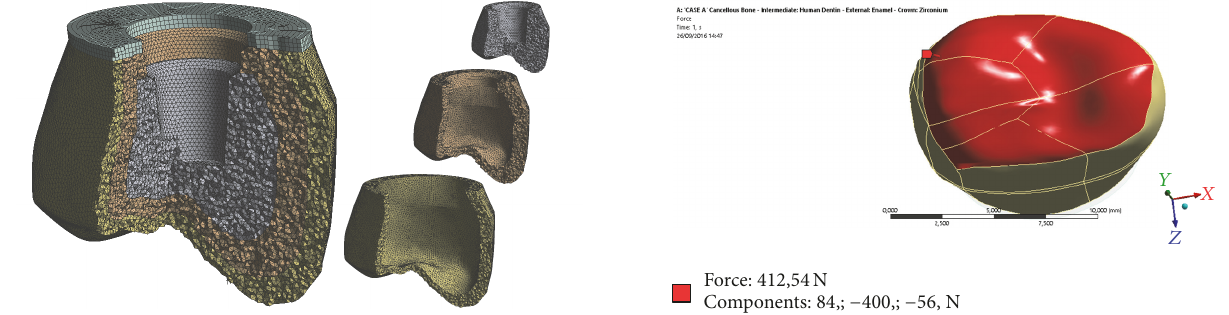
Figure 3: As earlier mentioned, the load chosen for the comparative analysis is not purely axial (purely axially along 𝑦 ) but shows a component along 𝑥 -axis (21%) and a component along 𝑦 -axis (14%).